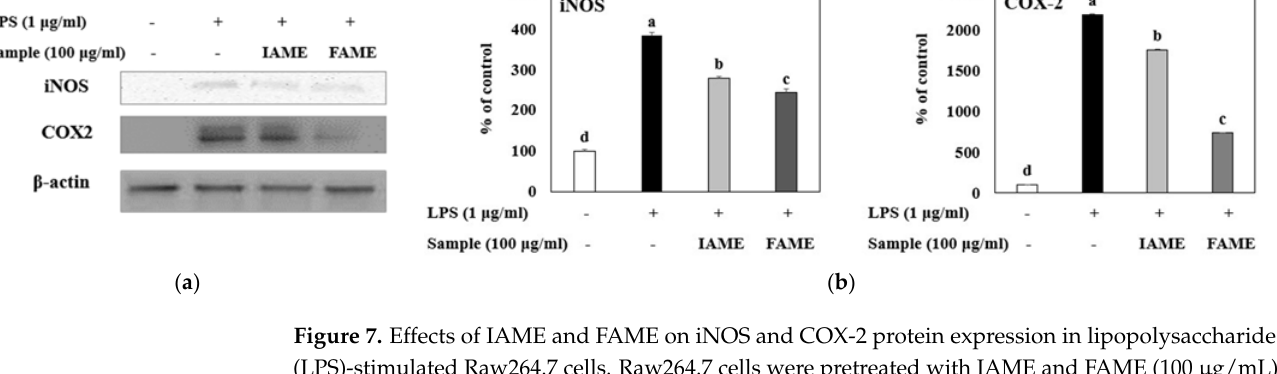
Figure 7. Effects of IAME and FAME on iNOS and COX ‐ 2 protein expression in lipopolysaccharide (LPS) ‐ stimulated Raw264.7 cells. Raw264.7 cells were pretreated with IAME and FAME (100 μ g/mL) for 2 h and then stimulated with LPS (1 μ g/mL) for 20 h. Equal amounts of cell lysates (30 μ g) were subjected to electrophoresis and analyzed for iNOS and COX ‐ 2 expression by performing Western blotting. Actin was used as an internal control. ( a ) iNOS and COX ‐ 2 protein expression. ( b ) Expres ‐ sion levels of iNOS and COX ‐ 2. Each value is expressed as the mean ± SD ( n = 3). a–d Values with different letters are different at p < 0.05, as analyzed by Duncan’s multiple range test. IAME, Abel ‐ moschus manihot extract; A. manihot extract fermented by Bacillus licheniformis CP6.